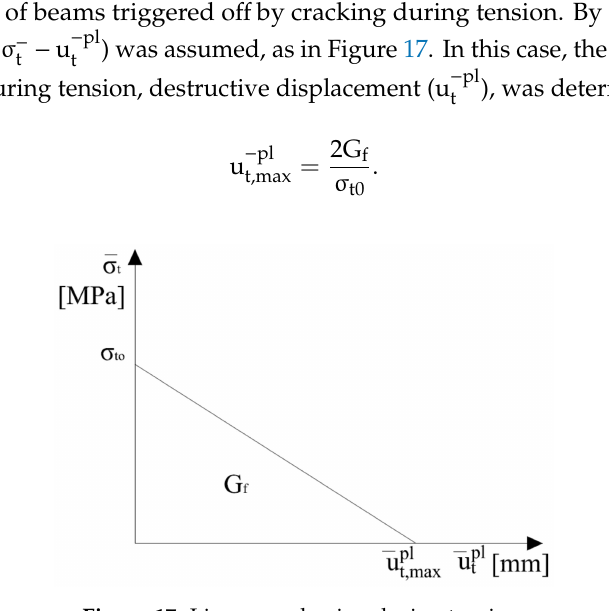
Figure 17. Linear weakening during tension.